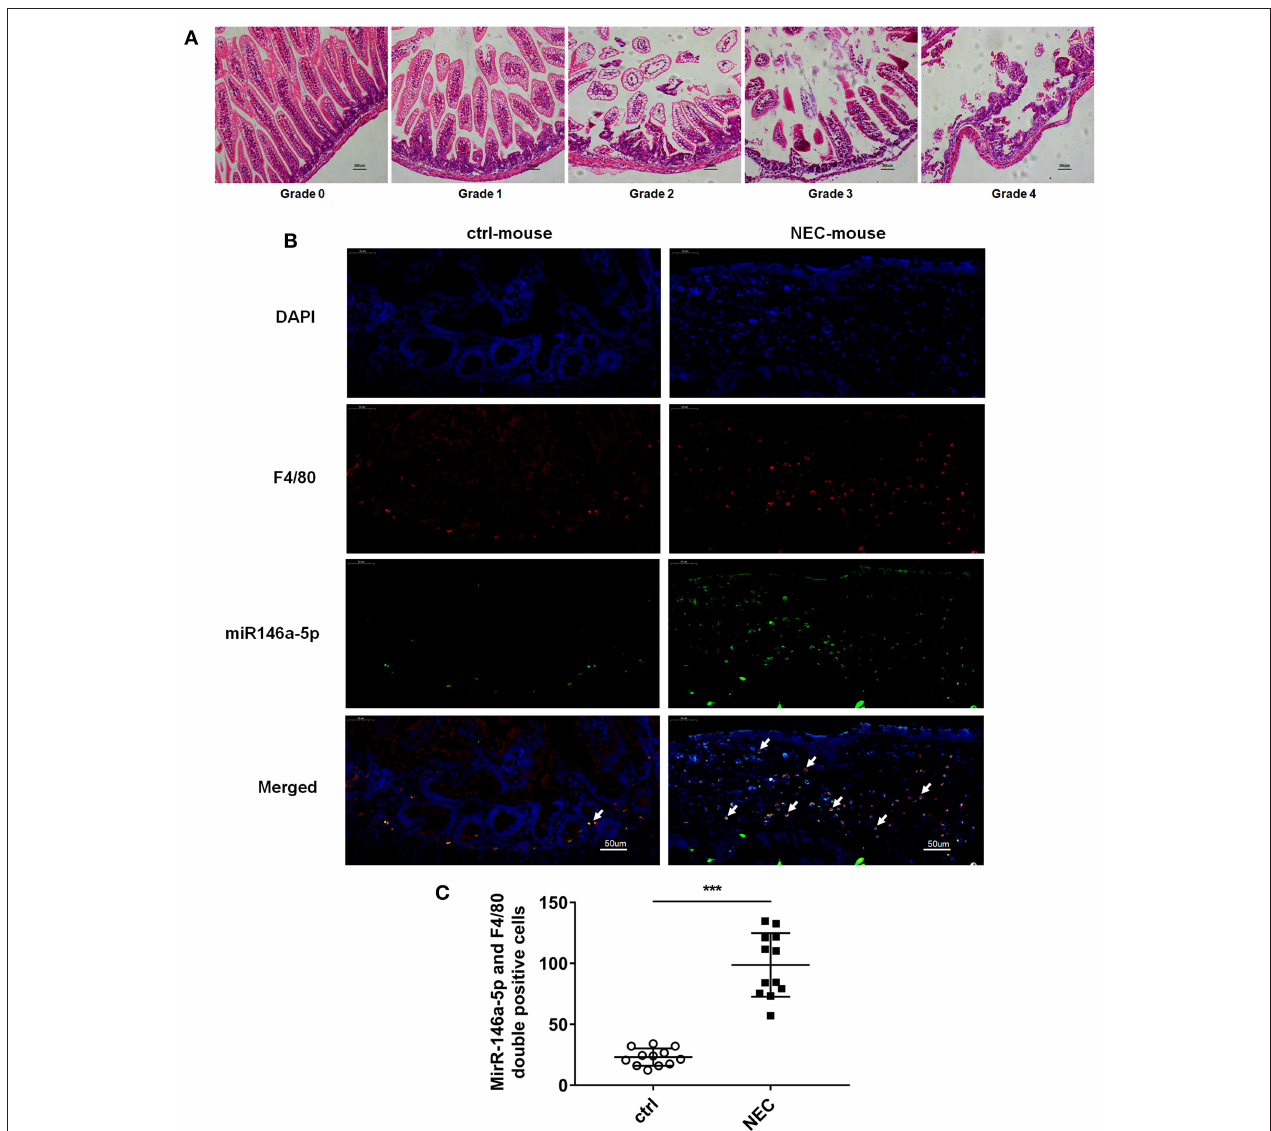
FIGURE 1 | MiR-146a-5p and F4/80 double-positive cells in the intestines of NEC mice. (A) Pathological grade of terminal ileum according to HE, Grade 0: normal ileum; Grade 1: mild injury to the tip of the villus; Grade 2: partial loss of the villus; Grade 3: severe submucosal injury; and Grade 4: complete necrosis. (B) FISH and immunofluorescence merged representative pictures of miR-146a-5p and F4/80 double-positive cells in intestinal tissues extracted from control and NEC mice. (C) The comparison of miR-146a-5p and F4/80 double-positive cell numbers in intestinal tissues between control and NEC mice ( n = 12 per group). *** P < 0.001.